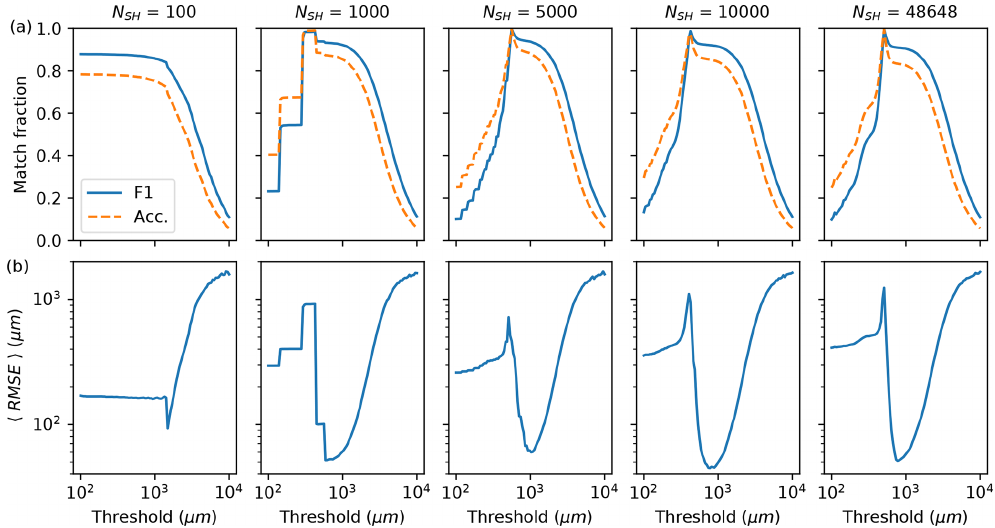
Figure 8. (a) The match accuracy and F1, and (b) the average RMSE for paired particles, are each plotted versus the match distance threshold. The columns show the results for the five models trained and optimized on synthetic and HOLODEC images with the number of planes used for reconstruction increasing from left to right.